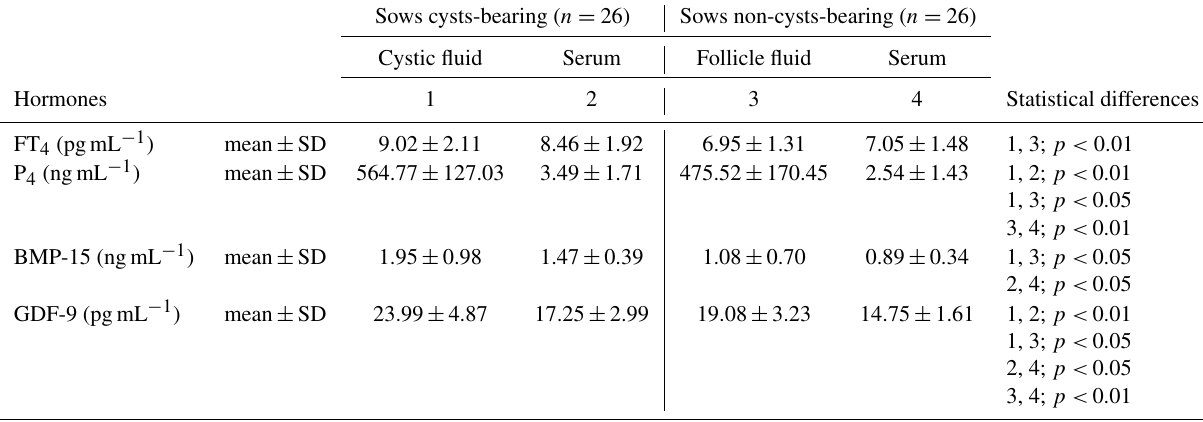
Table 1. FT 4 , P 4 , BMP-15, and GDF-9 concentrations in the ovarian cystic fluid, preovulatory follicular fluid, and the serum of sows. Sows cysts-bearing ( n = 26) Sows non-cysts-bearing ( n = 26)